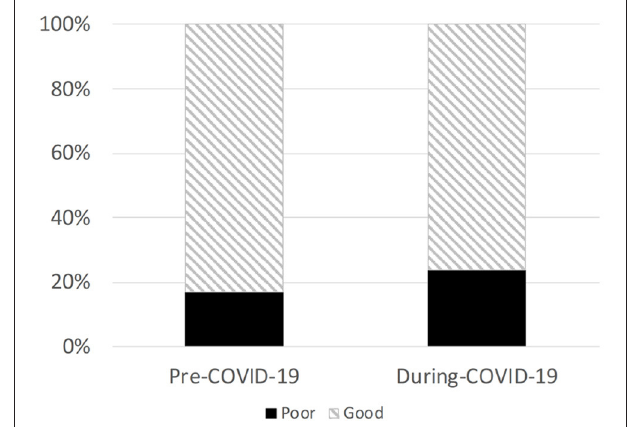
FIGURE 1 | Sleep quality pre- and during-COVID-19 social distancing restrictions. A significantly greater proportion of participants reported poor sleep quality during-COVID-19 compared to pre-COVID-19 ( p =